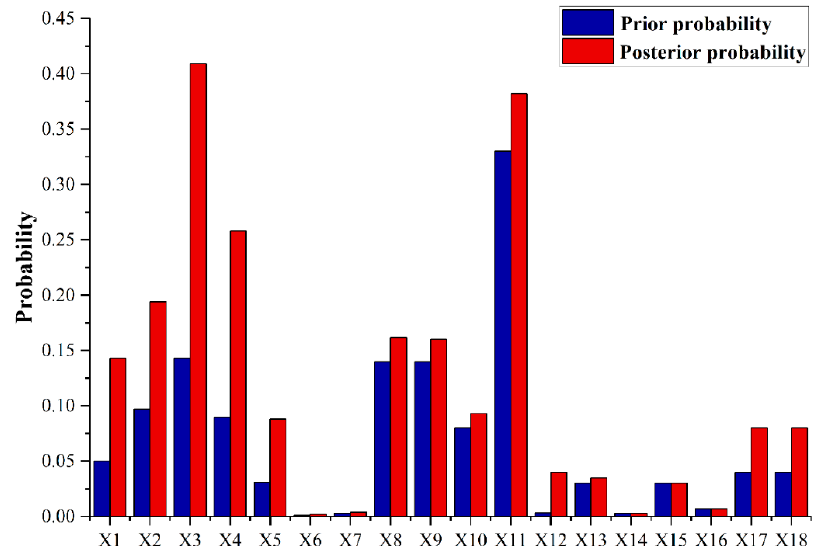
Figure 10. Root node probability map.